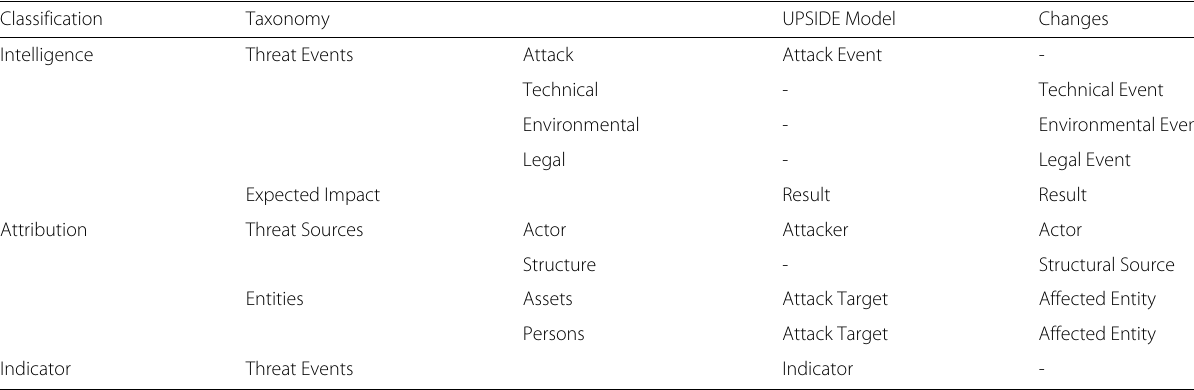
Table 1 CTI base model